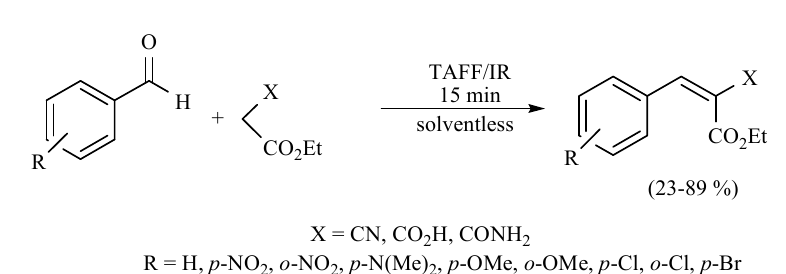
Synthesis of benzylidenemalononitriles,